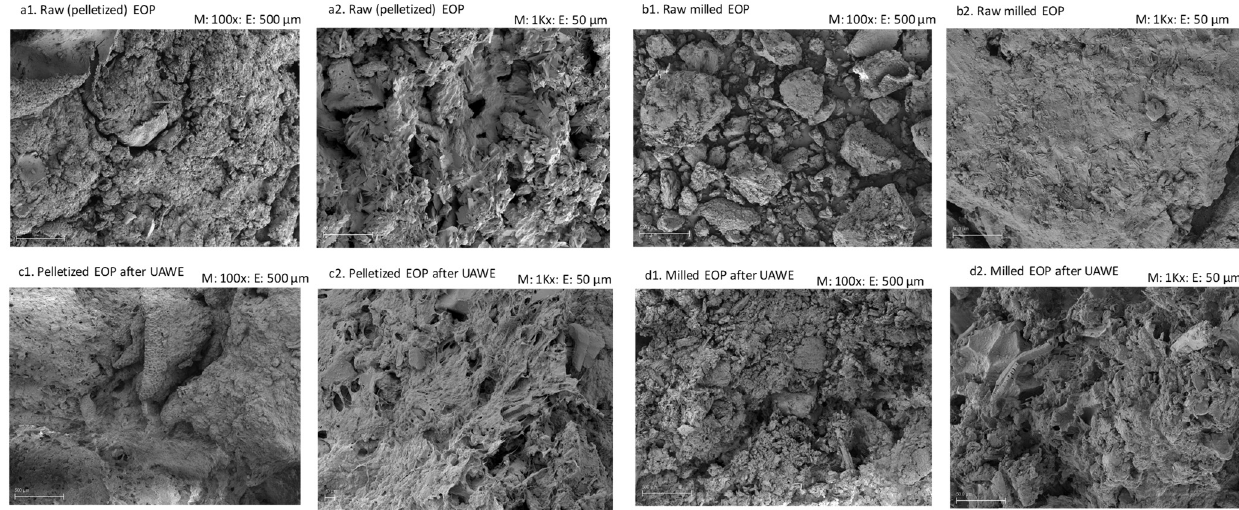
Figure 5. Scanning electron microscopy images at different magnifications of raw (pelletized) ( a1 and a2 ) and milled ( b1 and b2 ) exhausted olive pomace (EOP) and of their respective extracted EOP solids ( c1 and c2 and d1 and d2 , respectively) obtained after ultrasound-assisted water extraction (UAWE) at 80% amplitude, 16 min and 11.5% solid loading ( w/v ).